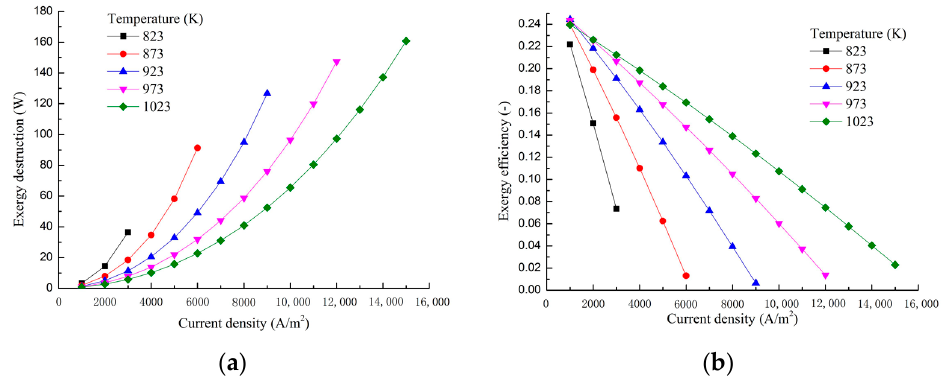
Figure 12. Exergy destruction ( a ) and exergy efficiency ( b ) for different current densities and different working temperatures.